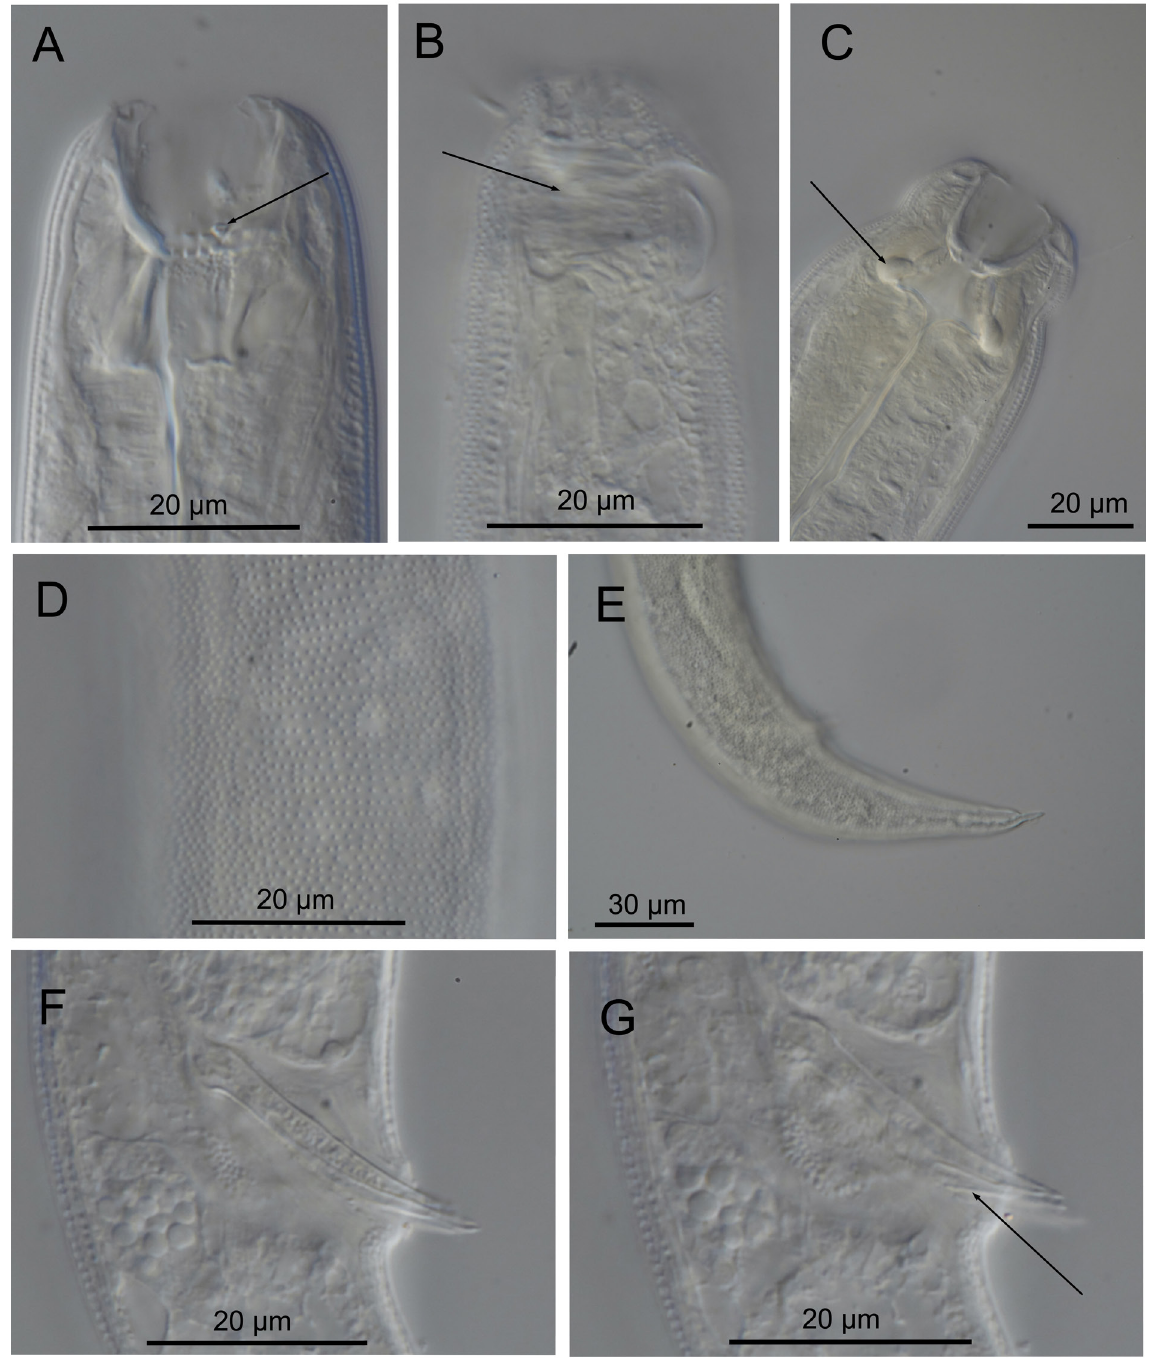
Fig. 7. Cobbionema brevispicula sp. nov. Light micrographs. A . Stoma of male holotype showing stoma armament, arrow pointing to the left ventrosublateral tine (SMNH Type-9219). B . Anterior part of male holotype showing sphincter muscle surrounding the anterior end of posterior stoma chamber (arrow) (SMNH Type-9219). C . Anterior part of a female; arrow pointing to a mandible with heavily cuticularized basal knob (SMNH-182041). D . Cuticle showing no lateral ala (SMNH Type-9219). E . Male tail (SMNH Type-9219). F . Caudal region of male holotype showing spicule (SMNH Type- 9219). G . Caudal region of male holotype showing crura (arrow) (SMNH